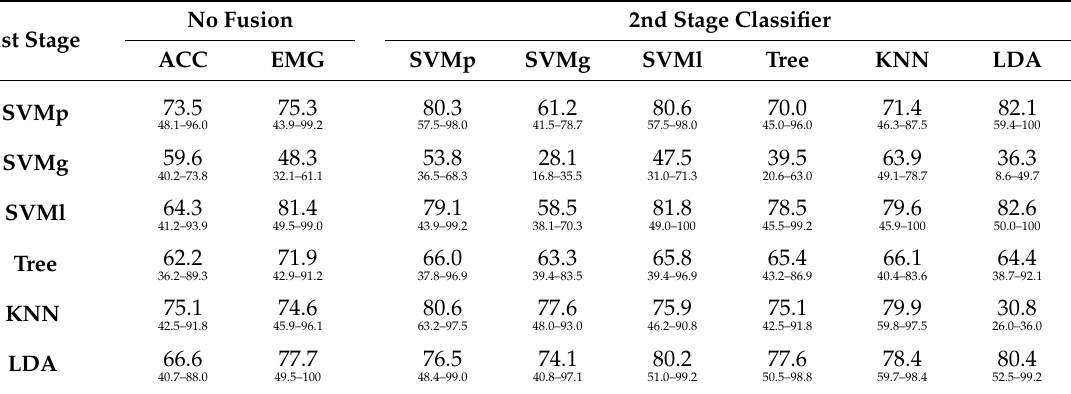
Table 3. Accuracy from the 2-stage classifier level fusion for different classifiers employed at the two stages, compared with the accuracy attainable without fusion using the same classifiers and only one set of features at a time. Reported figures are average percentages (top), together with minimum and maximum accuracies (bottom) achieved across all the possible 80%/20% train/test splits.